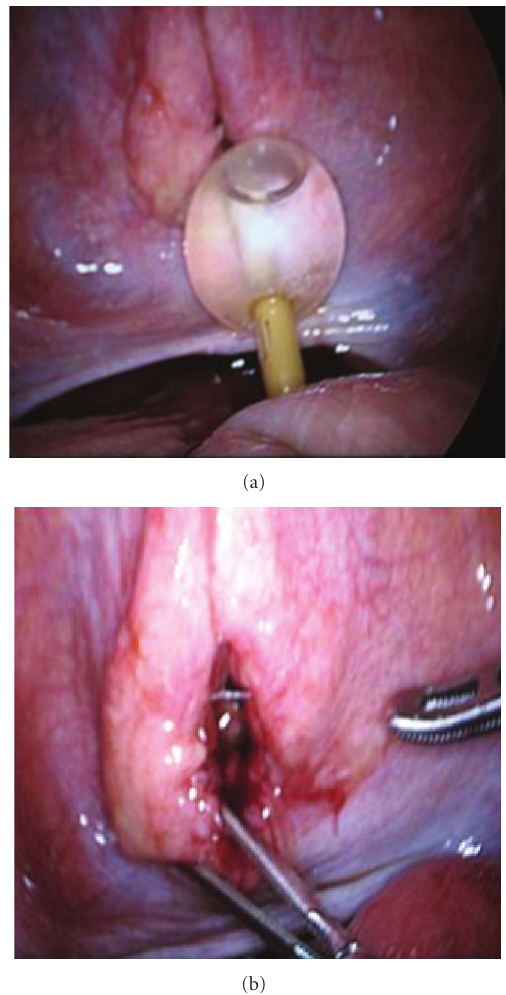
Figure 4: (a) Laparoscopic view showing Foley’s catheter balloon outside the UB and intraperitoneally. (b) The tear in the UB wall which was repaired laparoscopically.